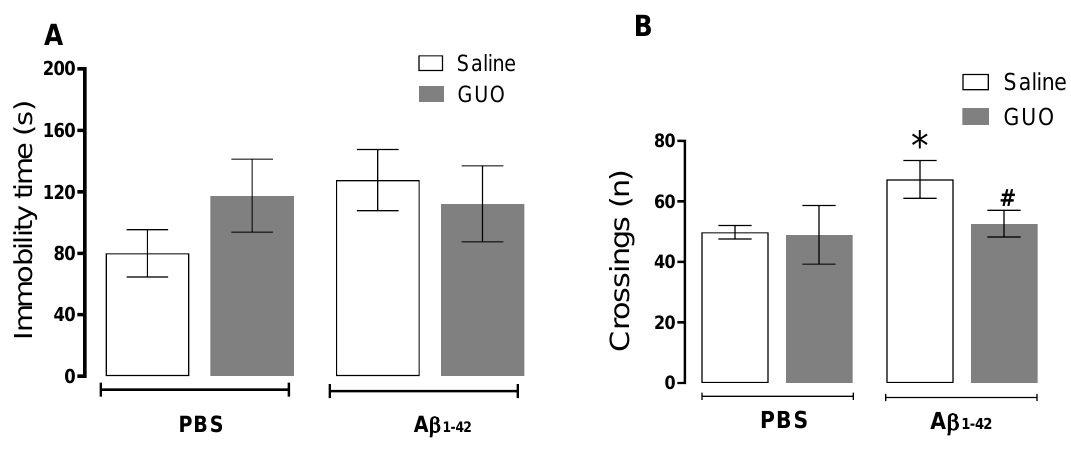
Figure 2. Evaluation of depressive- like behaviour in mice following guanosine treatment and Aβ 1 – 42 i.c.v. infusion. Mice subjected to Aβ 1 – 42 infusion (400 pmol/site, i.c.v.) received guanosine (GUO, 8 mg/kg, i.p.) for seven days. On the eighth day, mice were subjected to the tail suspension test ( A ) and to the open field test ( B ). Values expressed as mean + S.E.M (n = 6) * p < 0.05 compared with the vehicle-treated group; # p ≤ 0.05 compared with Aβ 1 – 42 -treated group . (Two-way ANOVA followed by Tukey’s test). Hippocampal slices of mice subject to A β 1–42 infusion and guanosine (Protocol 1—Figure 1A) treatment were evaluated for ROS production and cell viability. ROS production analysis showed that vehicle-treated and guanosine-treated groups did not present any alteration in ROS production. A β 1–42 infusion induced a 35% increase in ROS production when compared with the vehicle-treated group [( F (1,15) = 5.052, ( p = 0.0401)], and guanosine treatment prevented this effect [( F (1,15) = 6.165, ( p = 0.0253)] (Figure 3A). Regarding hippocampal viability, both guanosine treatment and A β 1–42 infusion did not alter hippocampal slice viability ( p ≥ 0.05) (Figure 3B), or cellular membrane integrity ( p ≥ 0.05) (Figure 3C) at this time point.